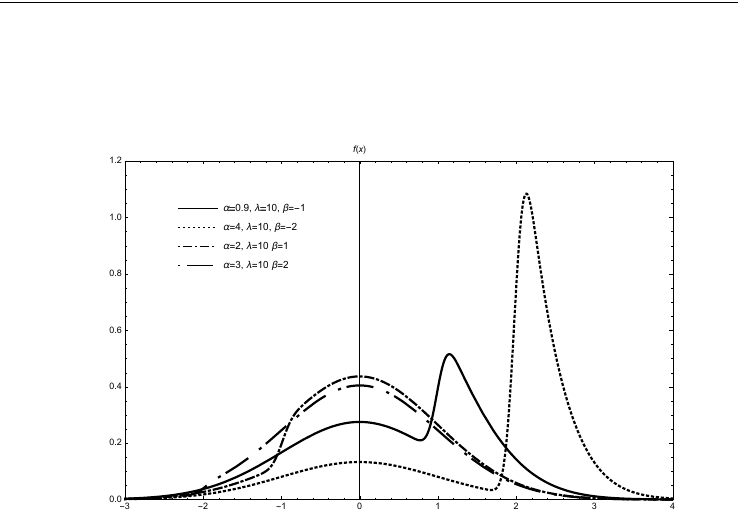
Figure 1 – Probability plots of GAND( α , λ , β ) for fixed values of λ and various values of α and β .